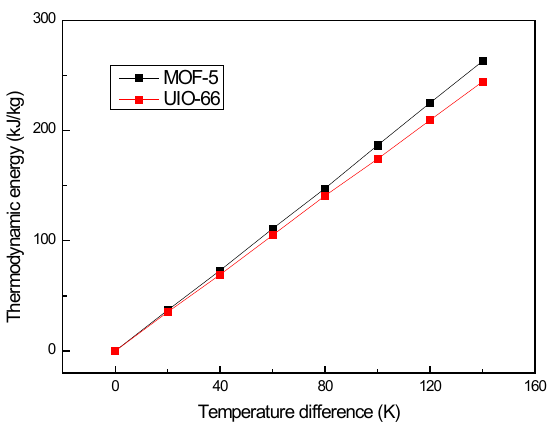
Figure 6: Thermodynamic energies of MOF-5 and UIO-66 particles at different temperature.